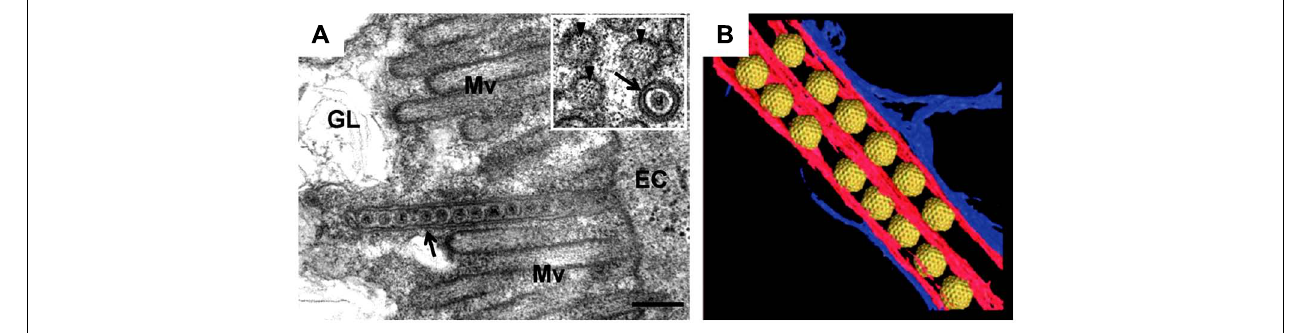
FIGURE 3 | Intercellular transport of Rice dwarf virus (RDV) in insect vector cells exploiting virus-induced Pns10 tubular structures. (A) Virus-containing Pns10 tubules associated with microvilli of anterior midgut in viruliferous leafhoppers. Inset, transverse section of microvillus containing a virus-packed Pns10 tubule approximately 100 nm in diameter.